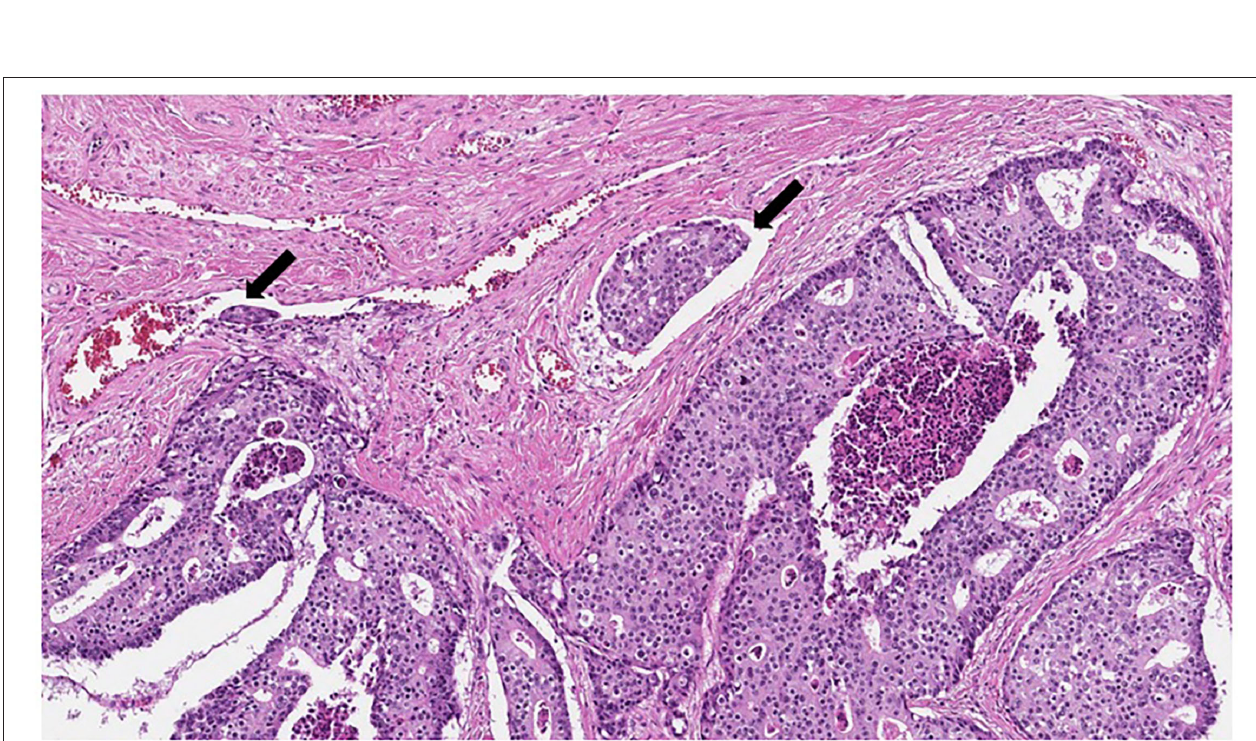
FIGURE 4 | Cribriform tumor structures with dirty necrosis. Lymphovascular invasion (marked with arrows) (HE, original magnification × 100).